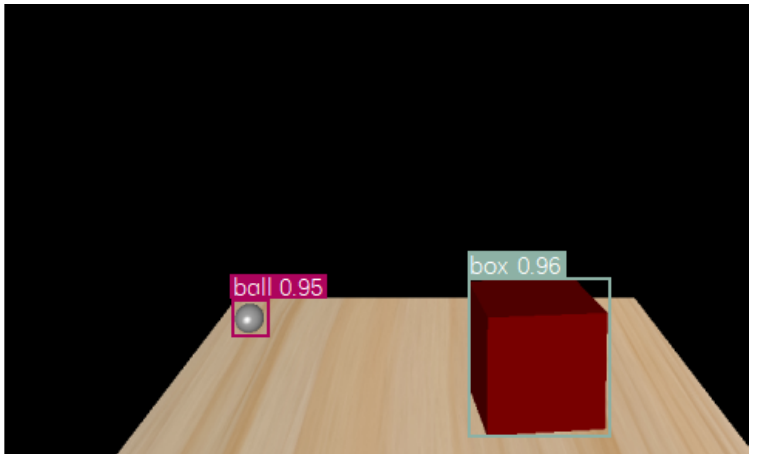
Figure 5. An example of object